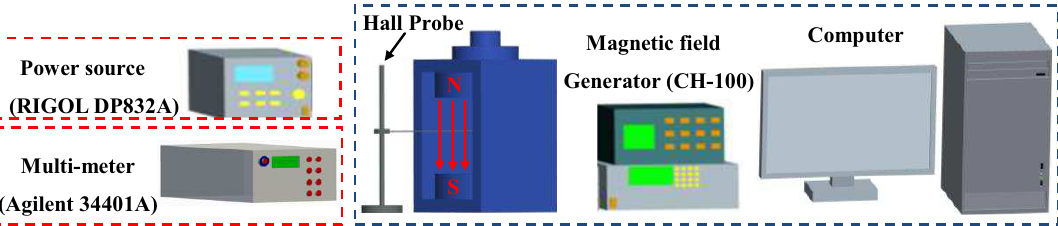
Figure 9. Testing system of the magnetic field